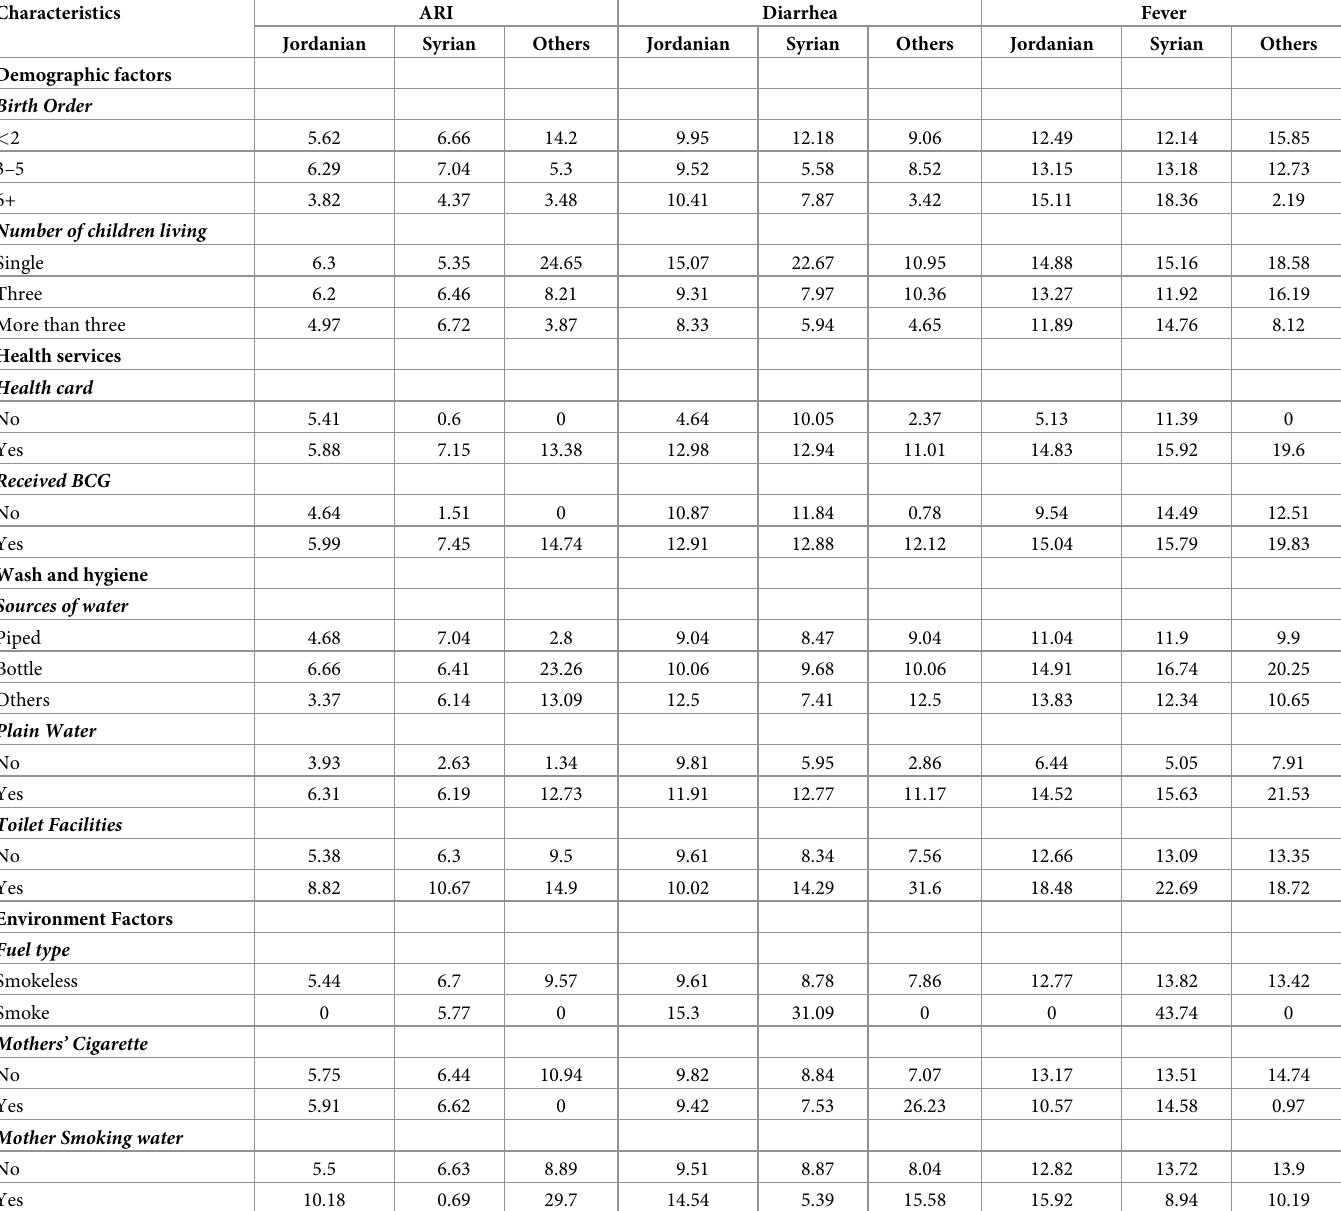
Table 4. Prevalence of acute respiratory infection, diarrhea and fever by demographic, health, hygiene and environmental characteristics among under-five chil- dren in Jordan, 2017–18.